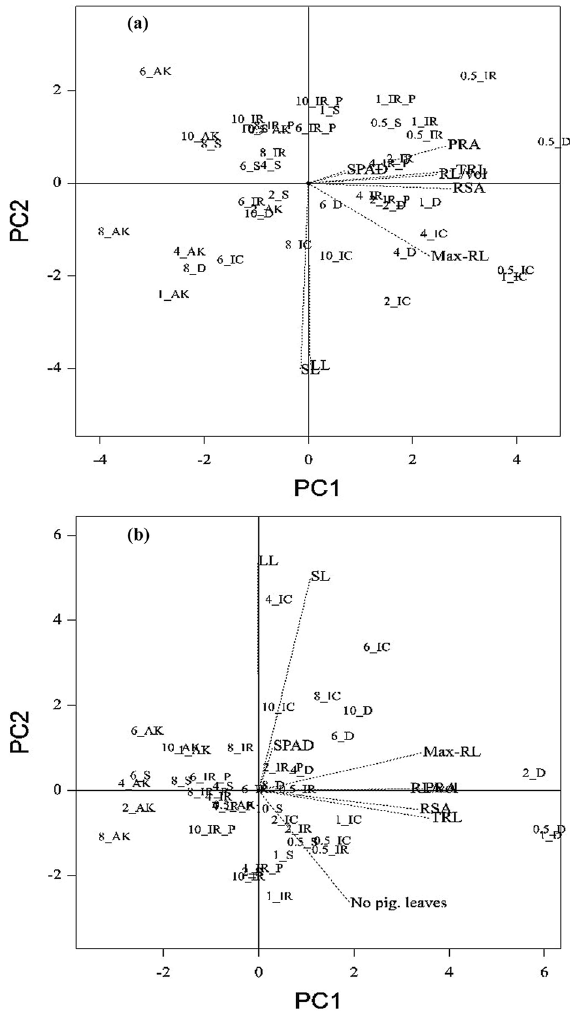
Figure 5. Genotype-by-trait biplot based on the variance exhibited by selected traits under different concentrations of phosphorus explained by two principal component axes: ( a ) 14 days after sowing and ( b ) 28 days after